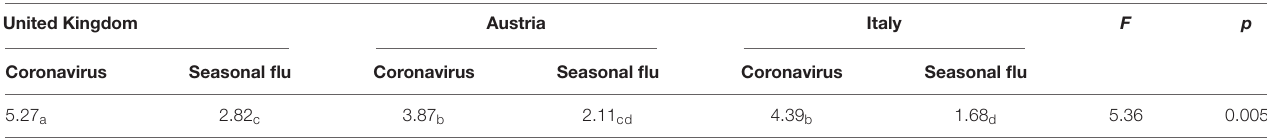
TABLE 3 | Analysis of the interaction of Country and Viral Disease on